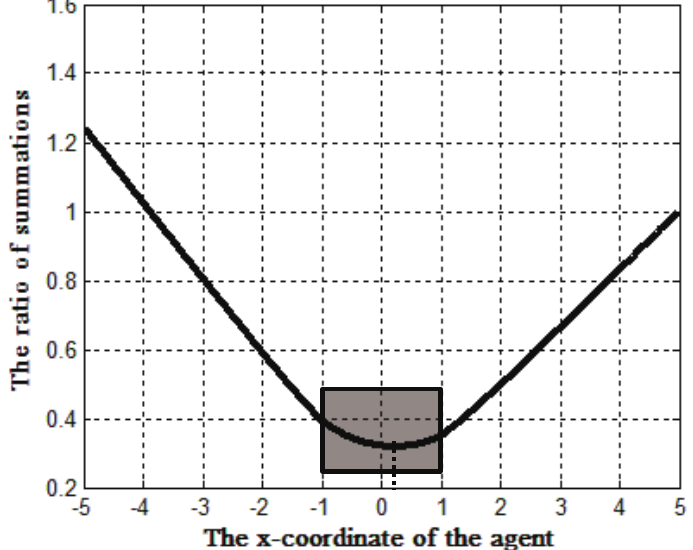
Figure 9. The efficiency of using a location